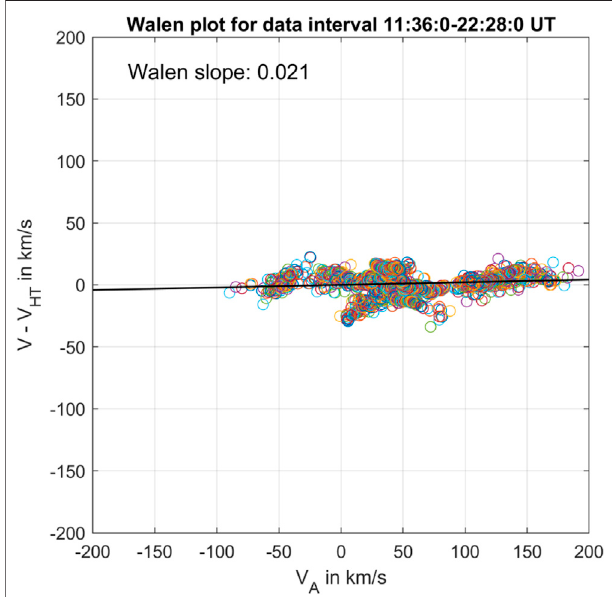
FIGURE 3 | The Walén plot for the MC interval at Wind for which the GS reconstruction is applied. The HT analysis yields an HT frame velocity [ − 346.52, − 10.81, 21.10] km/s, in the GSE coordinates. The slope of the regression line shown is denoted the Walén slope.